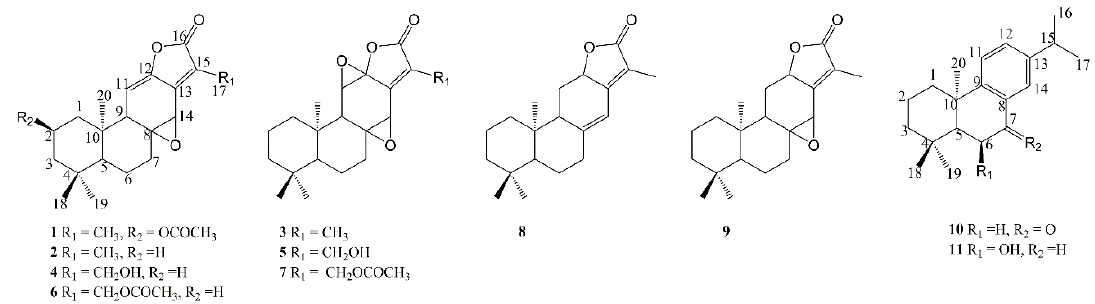
Figure 3. The isolated compounds ( 1 – 11 ). Table 2. In vitro cytotoxicity of 1 – 11 against MCF-10A, MCF-7, ZR-75-1 and MDA-MB-231 cell lines ( μ g·mL − 1 , Means ± S.D., n = 3).